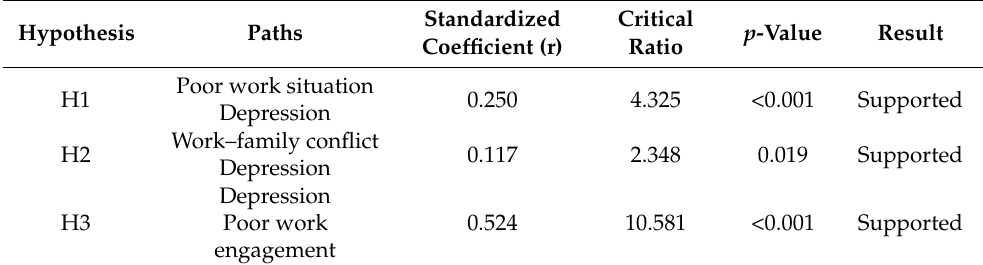
Table 5. Results of hypothesis testing for the proposed